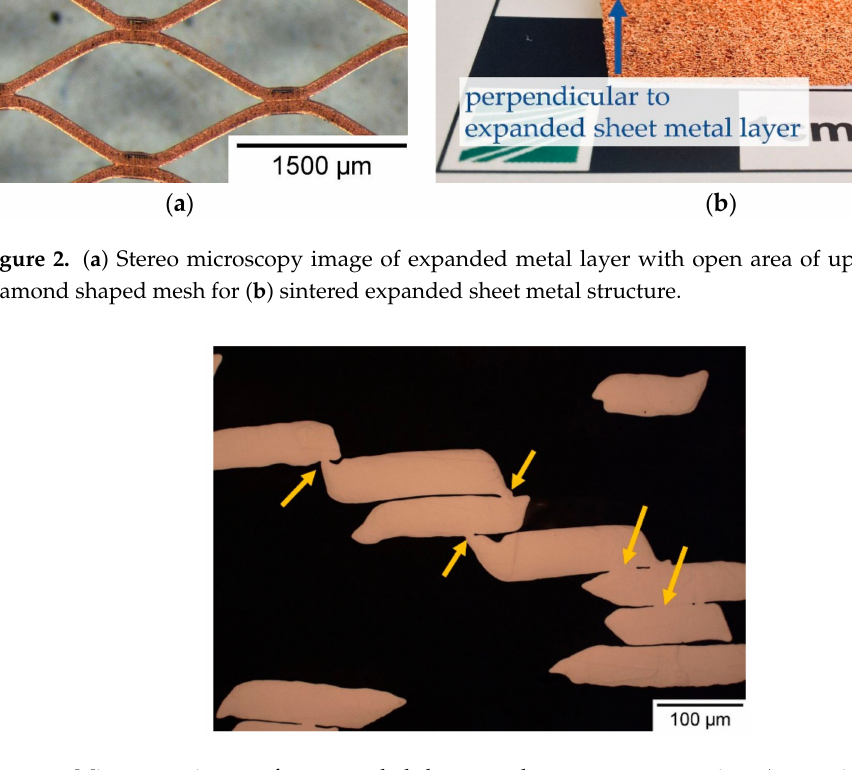
Figure 3. Microscopy image of an expanded sheet metal structure cross section. Arrows indicate sinter necks between single